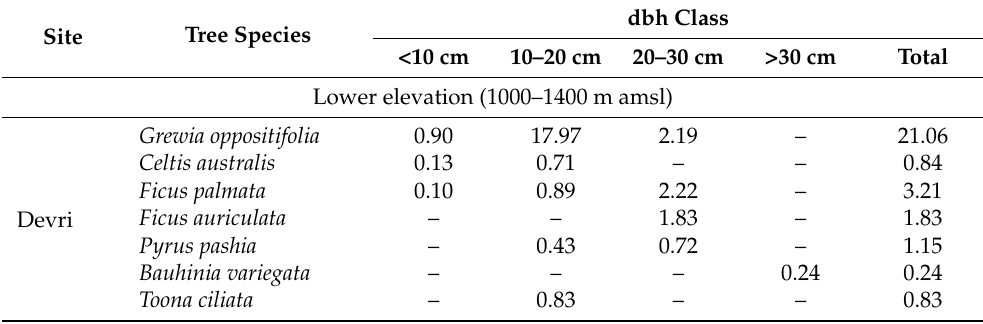
Table 7. Tree carbon stock (Mg ha − 1 ) of each tree species in G. oppositifolia -based traditional agro- forestry